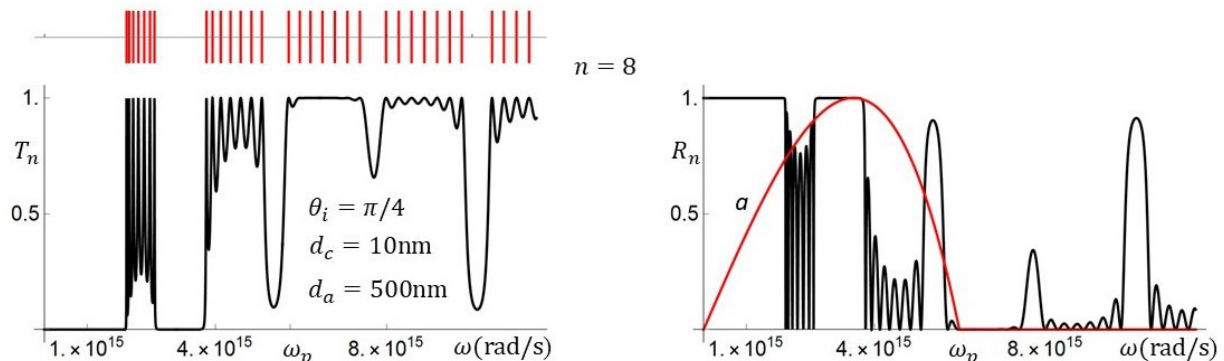
Figure 19. Transmission and reflection coefficients for a superlattice with n = 8, d a = 50 nm, d c = 10 nm, and incidence angle θ i = π /4. In the left, upper part, we show the predicted resonant frequencies from the dispersion relation. In the right is the absorption